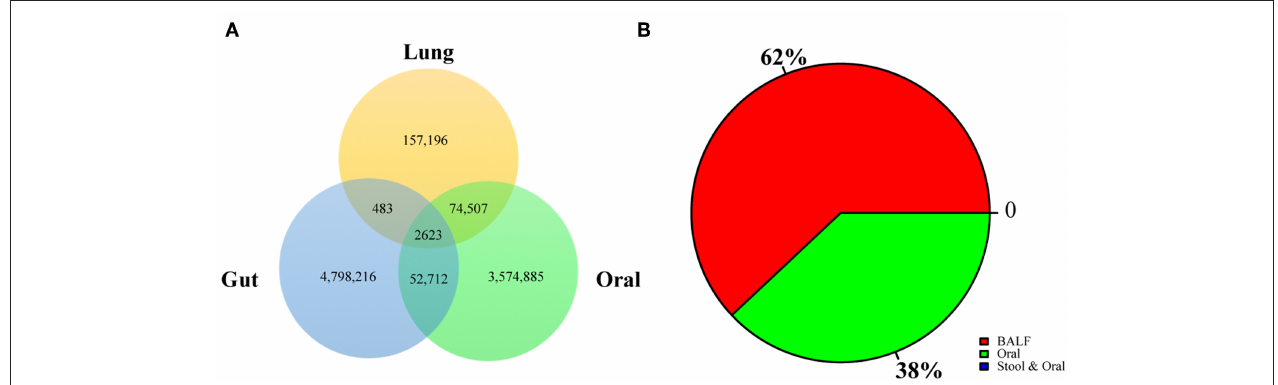
FIGURE 4 | Crosstalk of BALF’s microbiome to oral and gut microbiome. (A) The origin lung microbiome was explored by comparison with HOMD and HMP databases. The genes rescore was shown: 32.84% genes were from oral and 1.32% genes were from the gut, as determined by the Vsearch. (B) Crosstalk of the different enriched genes were analyzed in this research: 38% of them were from oral and rest of them were unique in BALF.